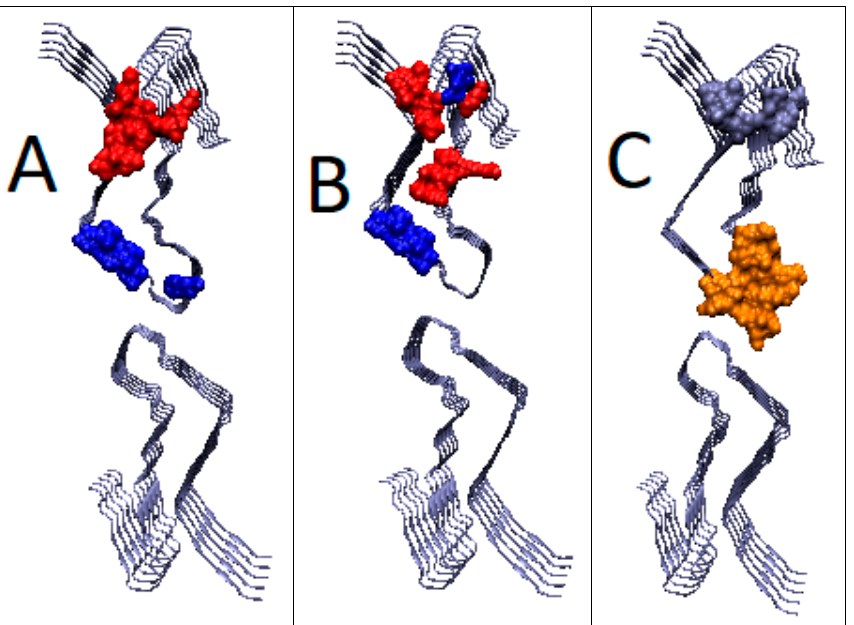
Figure 17. A set of profiles for amyloid showing a status significantly different from micelle-like with PDB ID 6LNI. ( A ) Individual chain; ( B ) status of chain in protofibril; ( C ) status in chain as part of super-fibril.